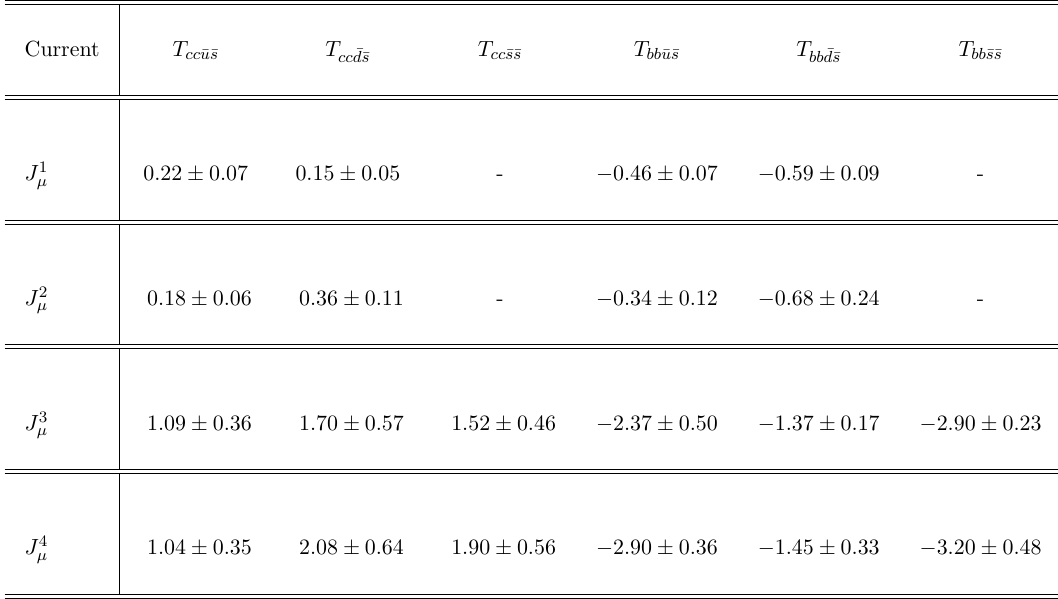
Table 2 . Numerical values of the MDMs for the T QQ ¯ q ¯ s and T QQ ¯ s ¯ s states, in units of nuclear magneton µ N